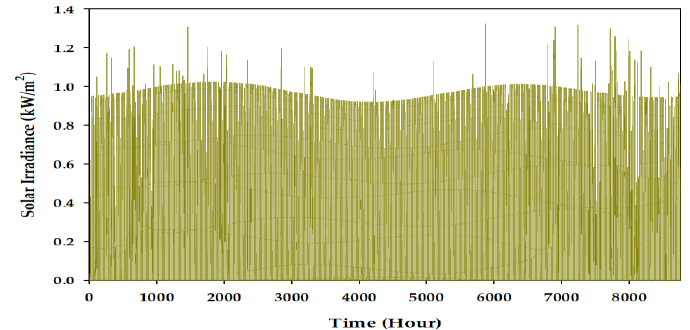
Figure 3. Solar Figure 3. Solar irradiance.